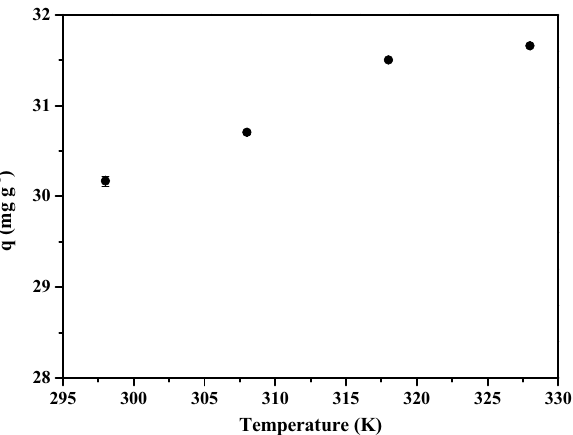
Figure 6. Effect of temperatures (298–328 K) on the adsorption capacities of Pt(IV) on Tu–N–SCG–C–A. Operating conditions: 250 mg of biocarbons and 50 mL of 80 mg L −1 Pt(IV) solution, pH =